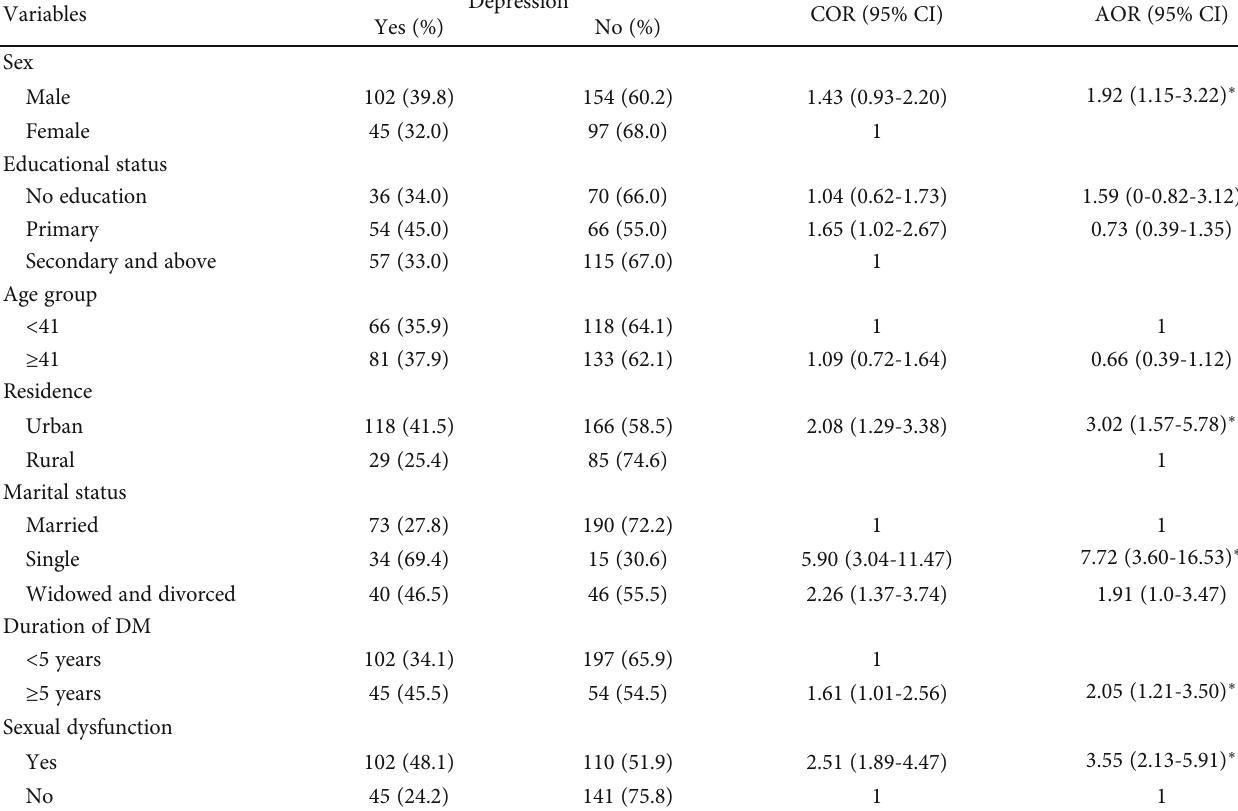
Table 3: Factors associated with depression among DM patients on follow-up at MTUTH and TGH, Southwest Ethiopia, July 2018.